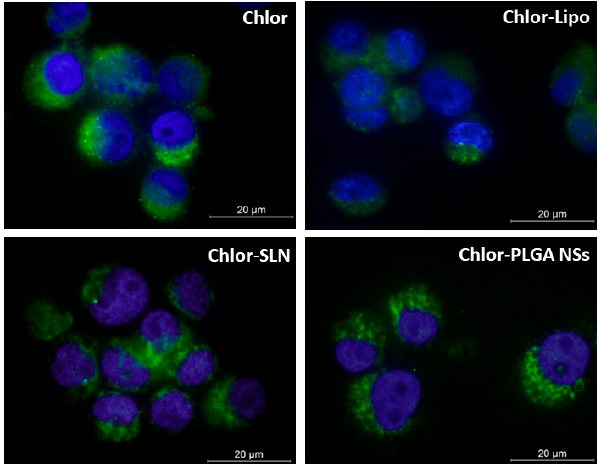
Figure 4. Representative fluorescence images of PC-3 cells incubated with the various Chlor formulations. Cells were incubated for 6 h with Chlor-Lipo or Chlor-SLN and for 24 h with Chlor or Chlor-PLGA NSs at the same Chlor concentration (5 µM); DAPI (blue) was used a nuclear counterstain. Magnification: 63×. Scale bars: 20 µm.